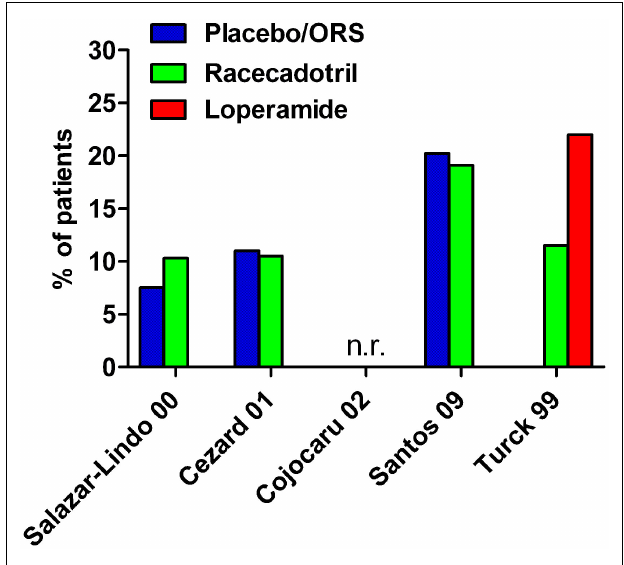
FIGURE 3 | Incidence of adverse events in controlled studies with racecadotril in the treatment of acute diarrhea in children. n.r., not reported; ORS, oral rehydration solution. Note that group differences did not reach statistical significance with the given number of patients. For study details see main text, for corresponding efficacy results see Table 2